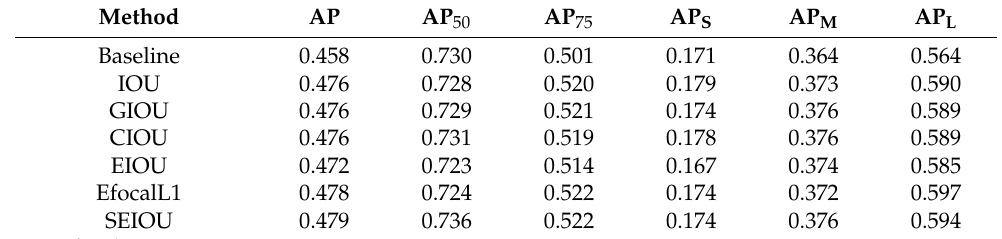
Table 1. Overall ablation studies on MOCS.